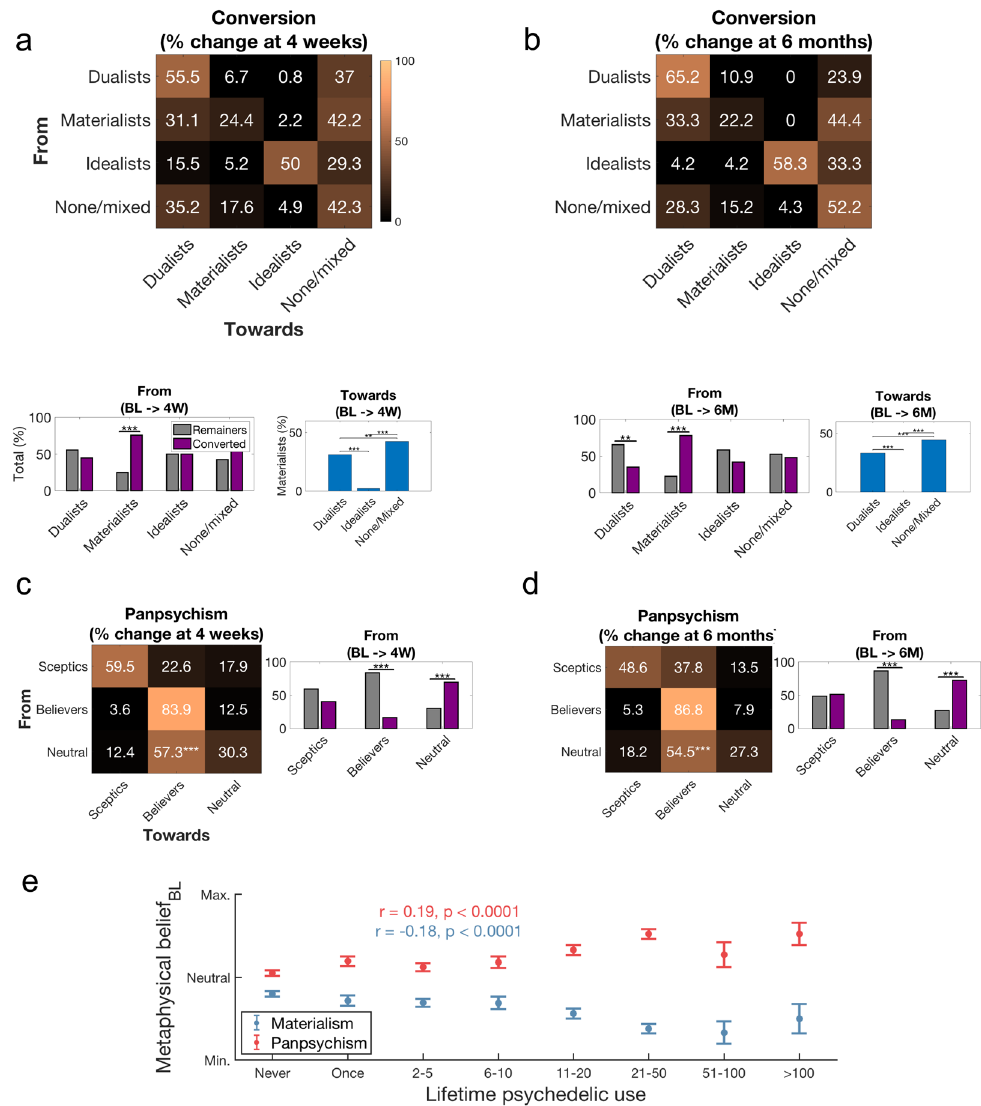
Figure 2. The nature of belief-shifts post-psychedelic-use. Matrices displaying the rate of belief-shift from and towards different ‘hard’ metaphysical positions are displayed at 4 weeks ( a -above) and 6 months ( b -above) following the ceremony. Significant rates of change were found only for respondents’ endorsing materialism at 4 weeks ( a -below) and 6 months ( b -below), with most of these ‘hard materialists’ leaning towards dualism or equanimity (or reduced hard materialism) post-ceremony. Significant rates of belief-shift were also found for respondents with non-committal views on panpsychism at baseline, who then shifted towards a panpsychist ‘believer’ stance at 4 weeks ( c ) and 6 months ( d ) post-ceremony. ( e ) Lifetime psychedelic use was positively correlated with panpsychist views and negatively correlated with hard materialistic views measured at baseline. (*p < 0.05, **p < 0.01, ***p <